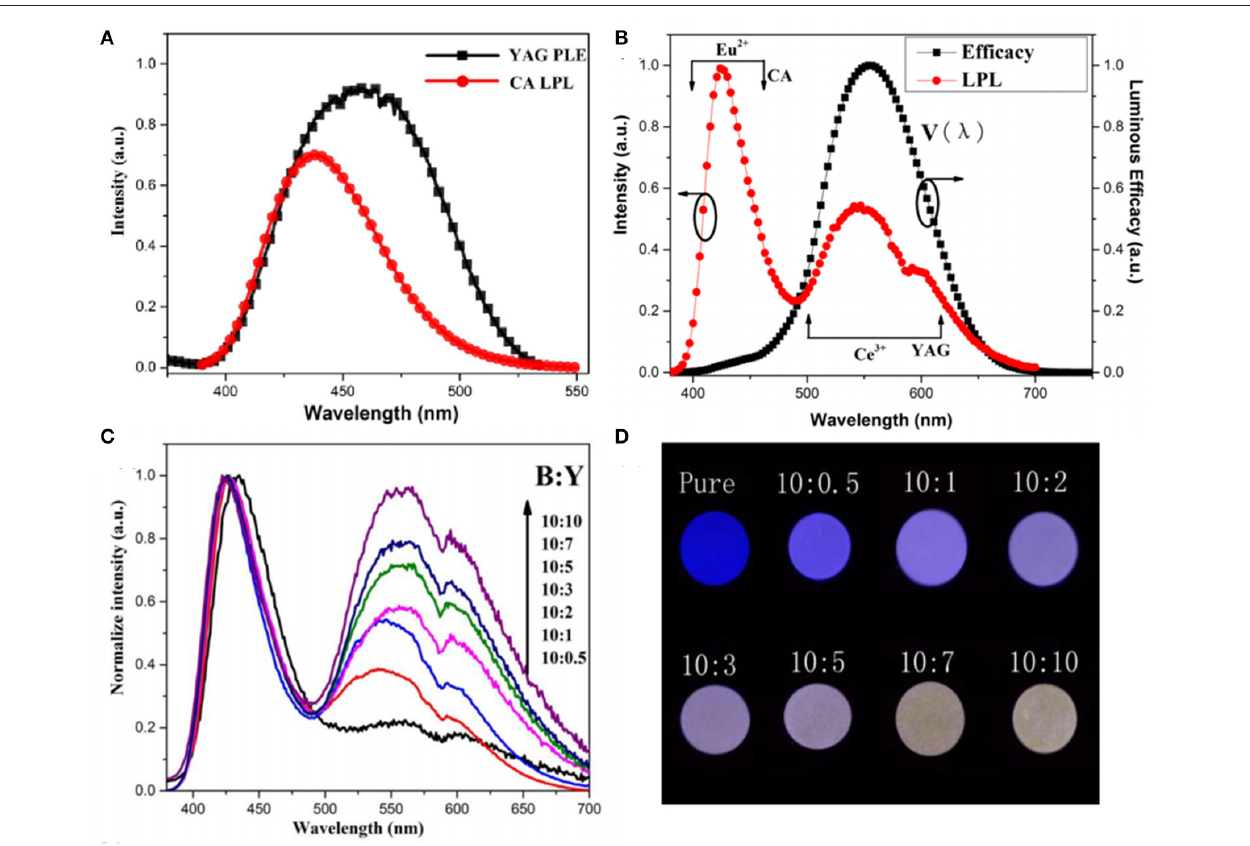
FIGURE 7 | (A) The LPL spectrum of CA and the PLE spectrum of YAG. (B) The LPL spectrum of composition with B:Y = 10:3 (red line) and the luminous efficiency in photopic vision (black line). (C) The normalized LPL spectra of composites with different B:Y weight ratios. (D) LPL photographs of composites after exposing to UV lights for 5min. Reproduced from Chen et al. (2016) with permission from The Royal Society of